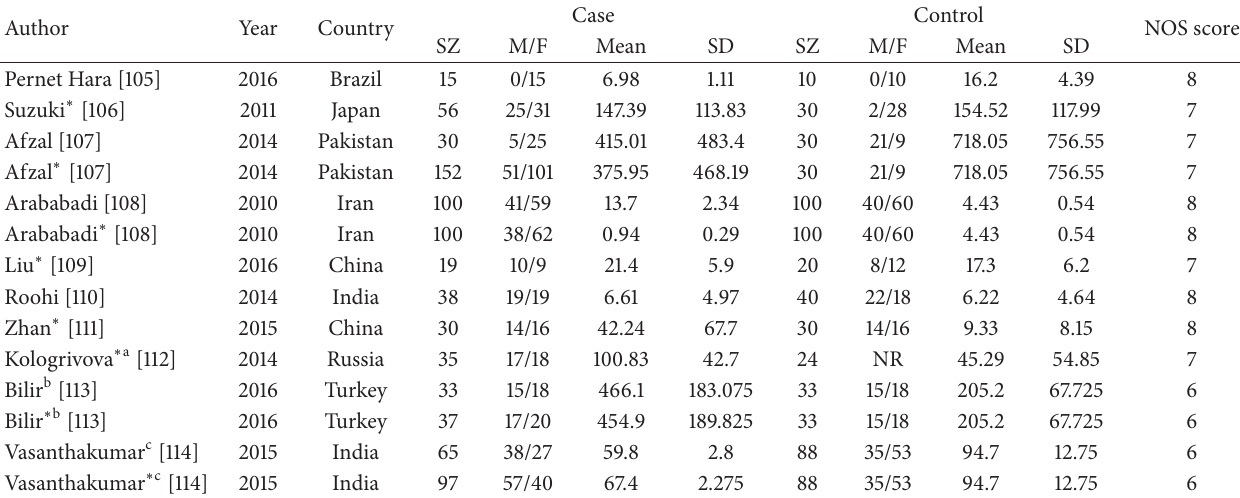
Table 7: Characteristics of studies about IL-17 (pg/mL) included in this